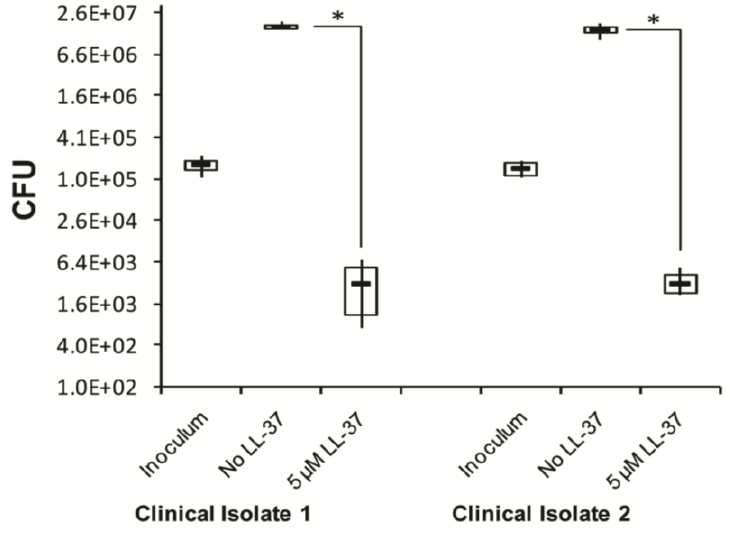
Figure 6. Inhibitory effect of synthetic LL-37 peptide on clinical isolates of Clostridium difficile . Two clinical isolates of C. difficile that were metronidazole and vancomycin sensitive but resistant to ciprofloxacin were treated with or without LL-37 peptide in MHB in wells of microtiter plate. Bacterial suspensions from individual wells were plated on blood-agar for counting of CFU. Lower and upper boundaries of the boxes and the horizontal bars in between indicate 25th percentile, 75th percentile and group median, respectively. Vertical lines through the boxes join the minimum and maximum